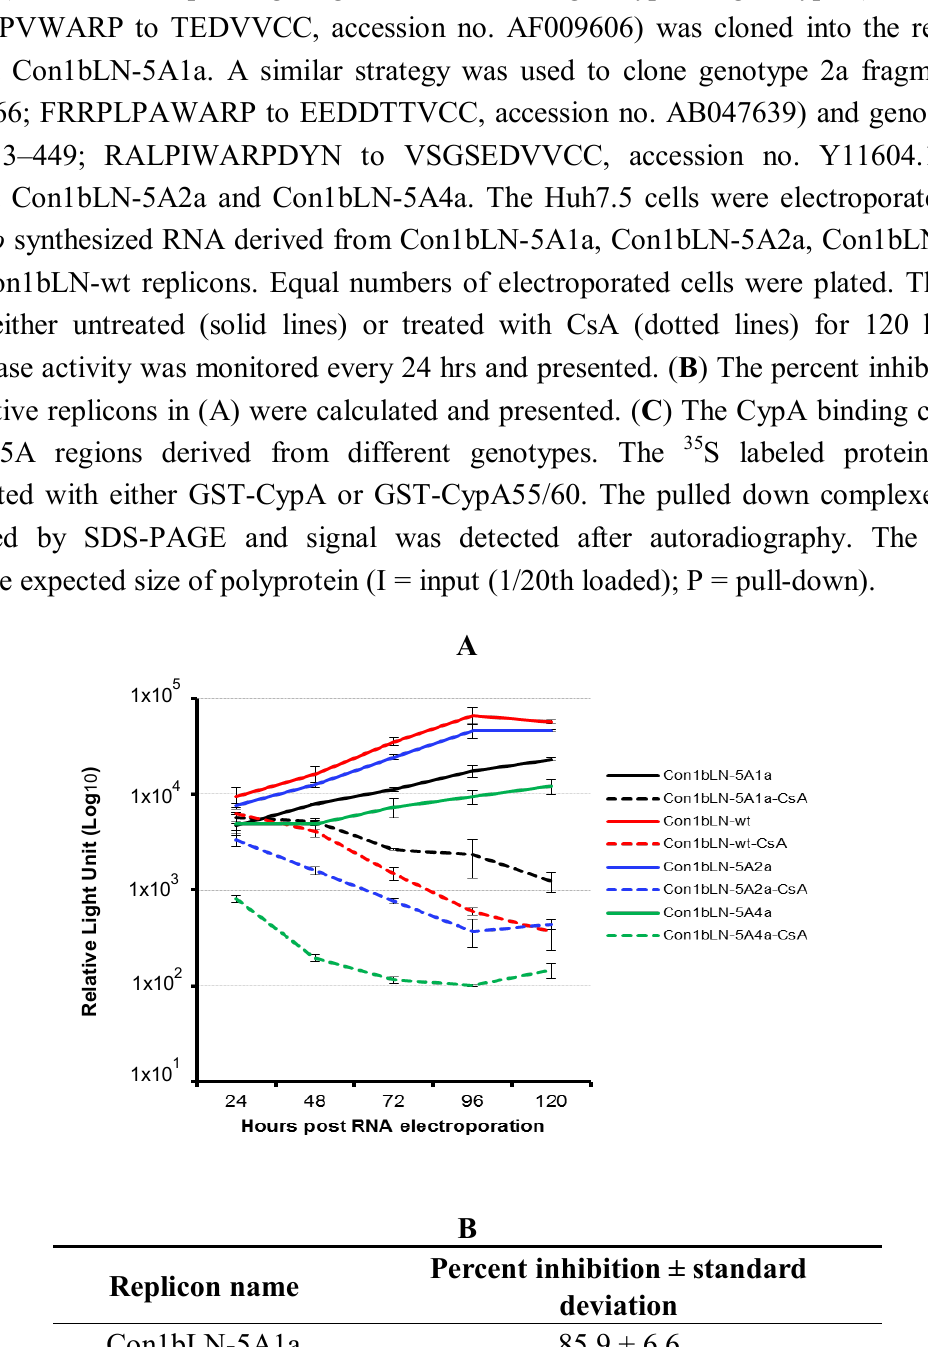
Figure 1. Role of HCV NS5A C-tails in CsA susceptibility and CypA binding. ( A ) The Con1bLN replicon was digested with XhoI and BstZ17I restriction enzymes (New England Biolabs) and a corresponding fragment from HCV genotype 1a genotype (aa